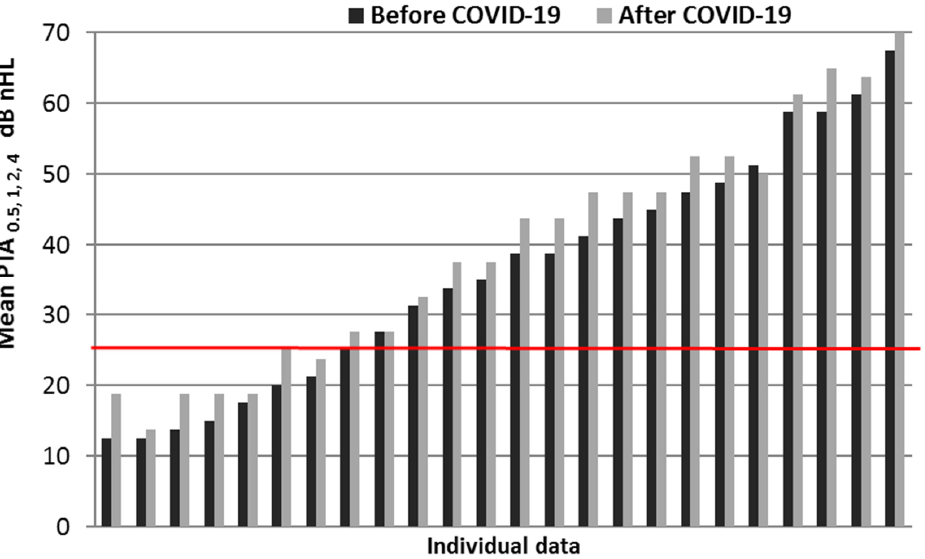
Figure 2. Individual PTA data for the right ear (air conduction) before and after COVID-19. The boundary line of “normal” hearing (mean PTA 0.5, 1, 2, 4 = 25 dB) is highlighted. Table 2. Results of extended speech testing of patients after COVID-19 ( n = 24, 48